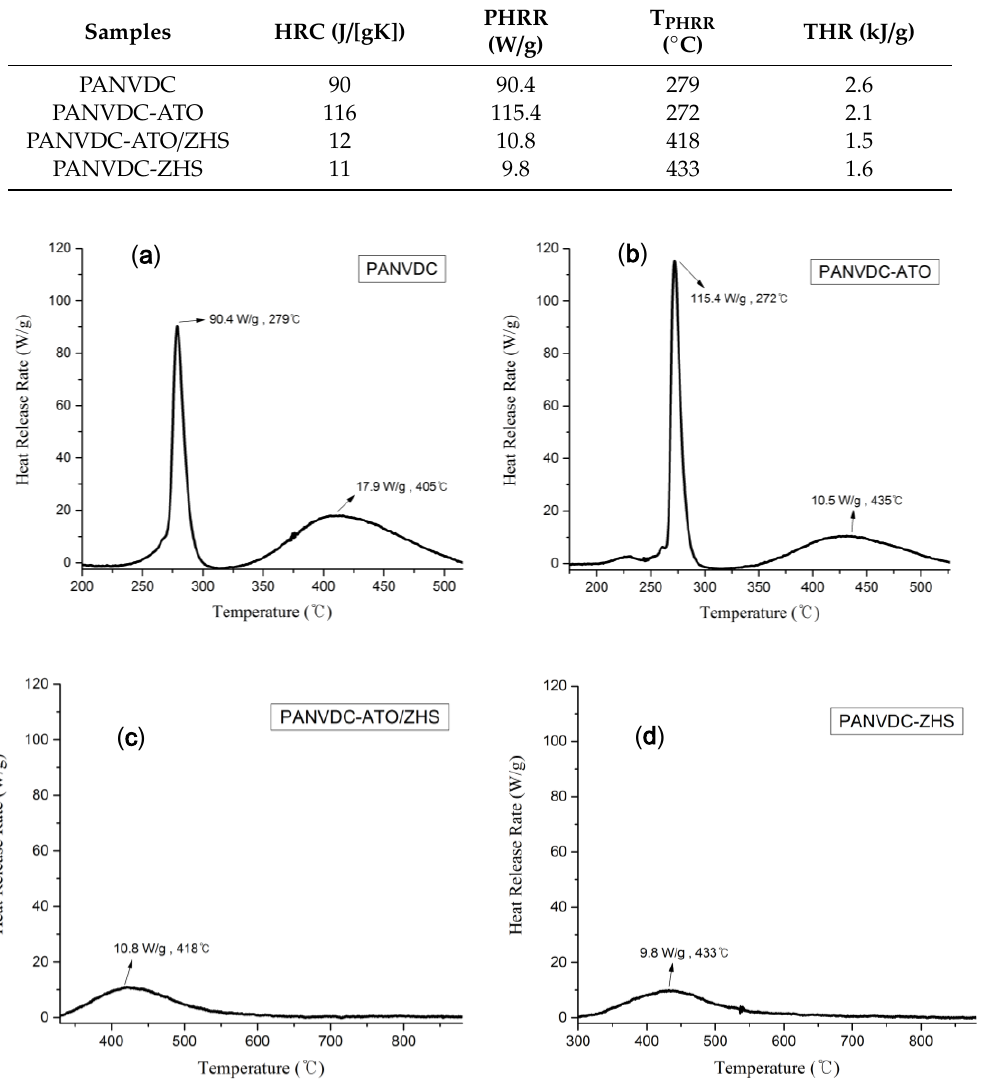
Figure 6. The heat release rate versus temperature curves of PANVDC fibers: ( a ) PANVDC, ( b ) PANVDC-ATO, ( c ) PANVDC-ATO/ZHS, and ( d ) PANVDC-ZHS.